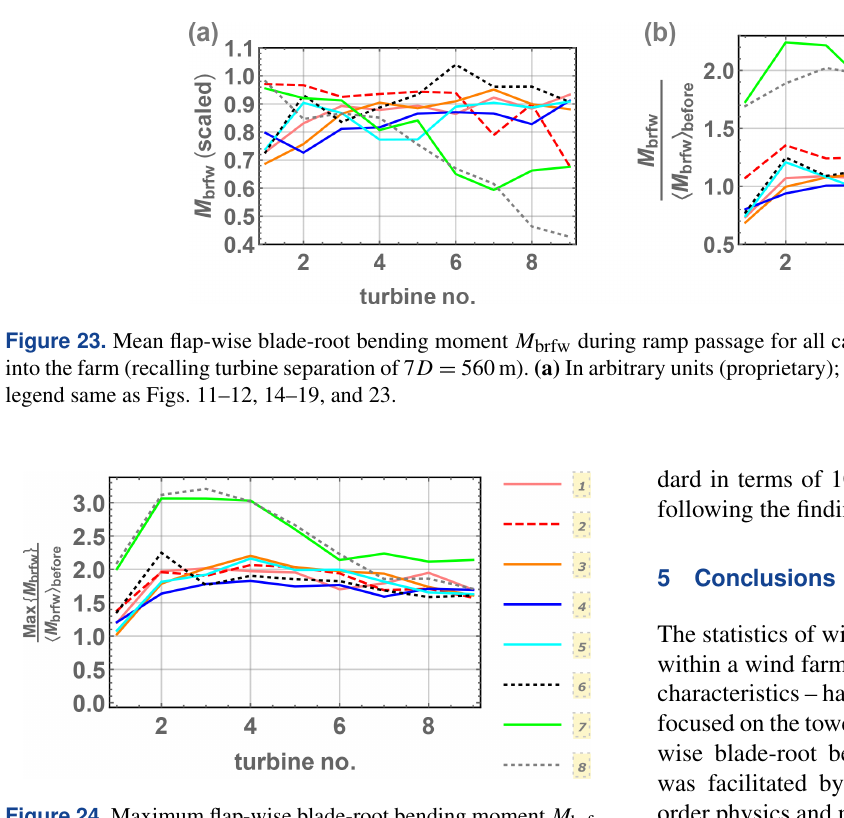
Figure 24. Maximum flap-wise blade-root bending moment M brfw for all ramp cases from coupled LES, as a function of distance into the farm (turbine number, where turbine separation is